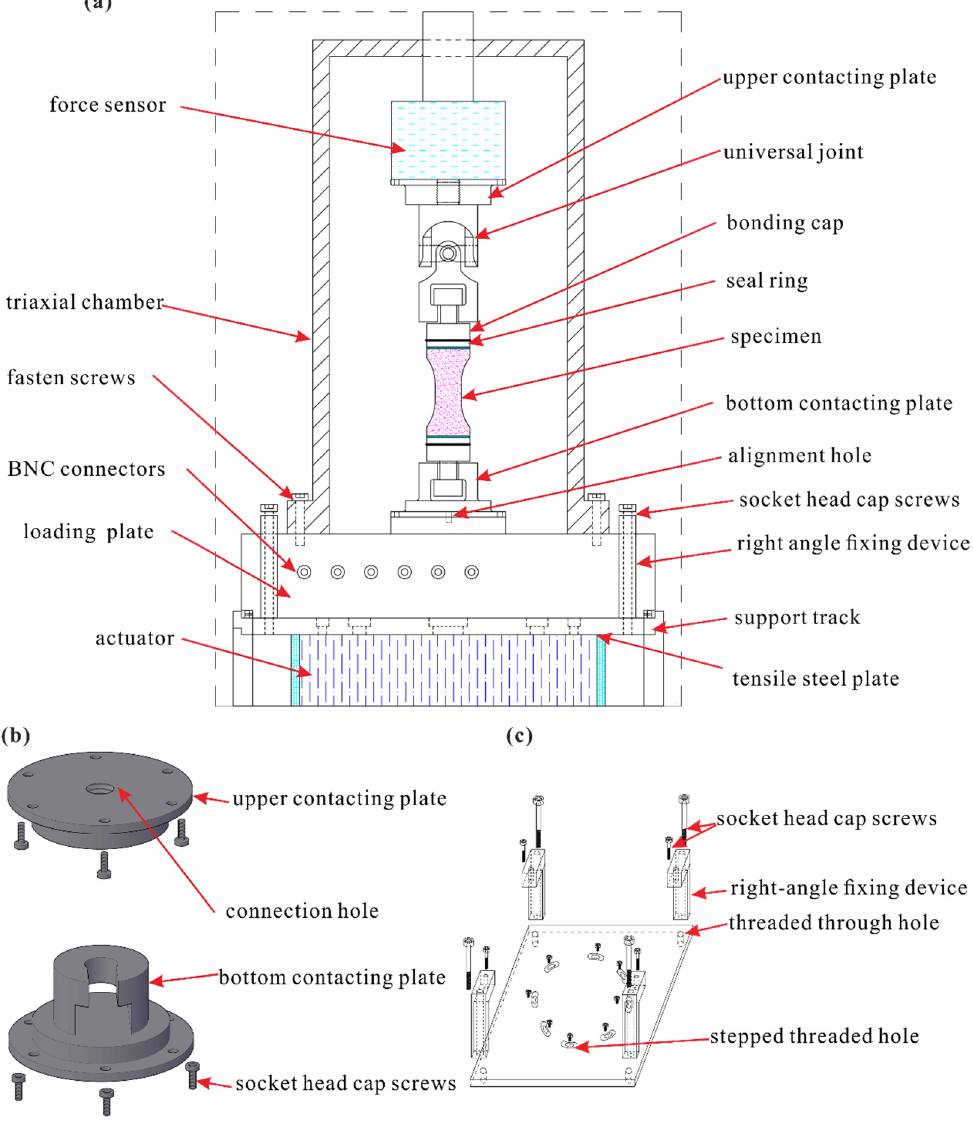
Figure 3. Test machine transformation: ( a ) MTS815 testing machine with a clamp device, ( b ) upper and bottom contacting devices, ( c ) tensile steel plane and its fixing device.